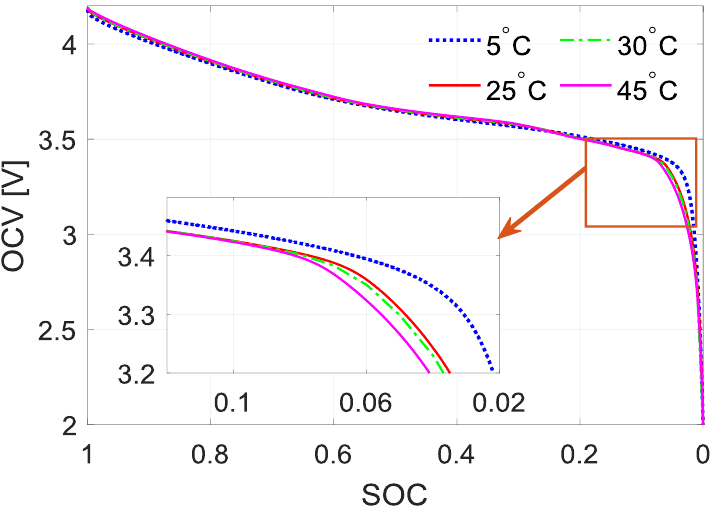
Figure 3. The experimental OCV–SOC curves for NMC battery at different temperatures.